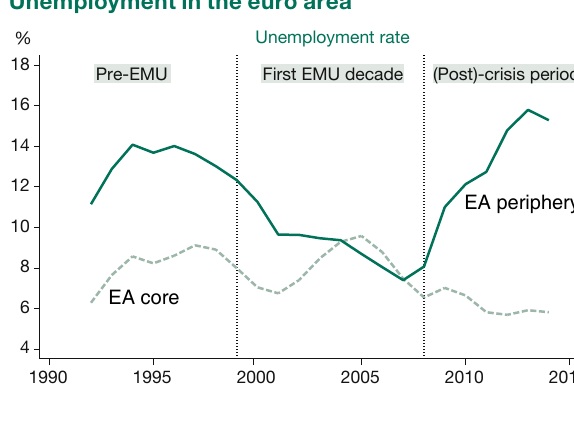
Note: Core and periphery defi ned as before. Source: Eurostat.